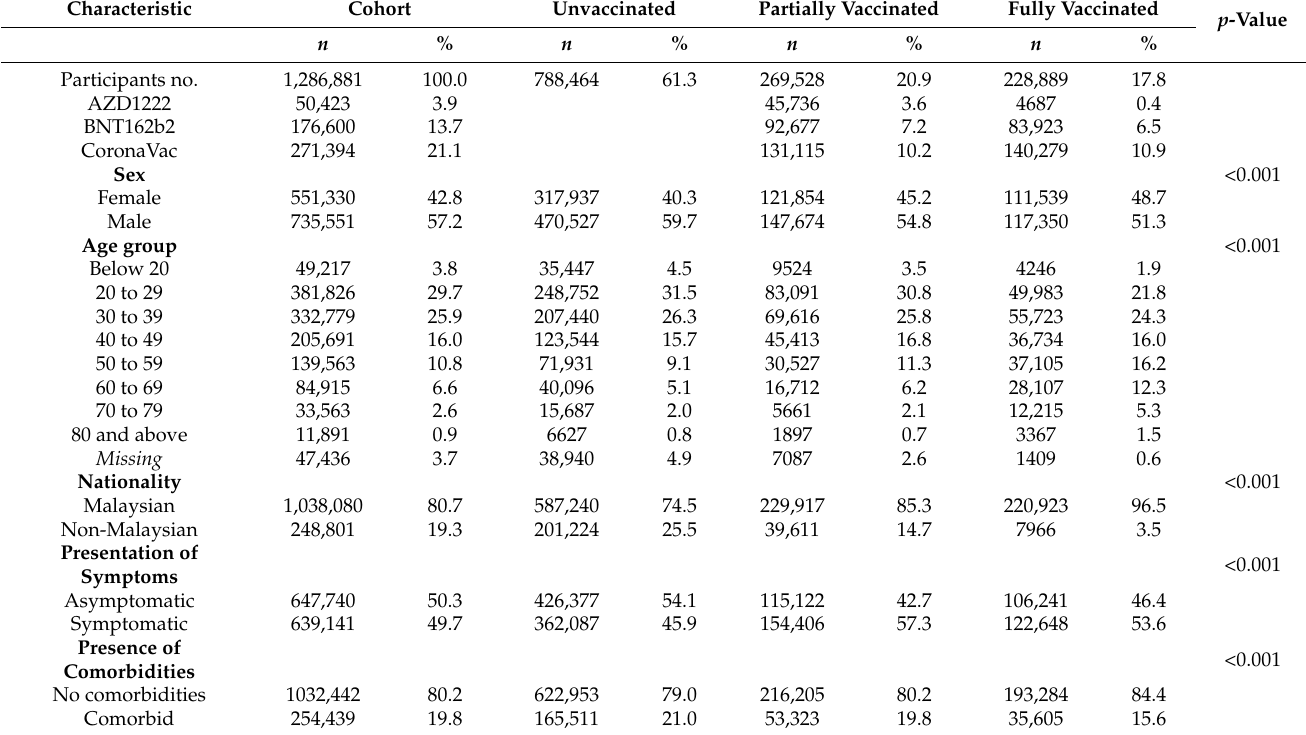
Table 2. Characteristics of the study cohort of confirmed COVID-19 cases, according to vaccination status.